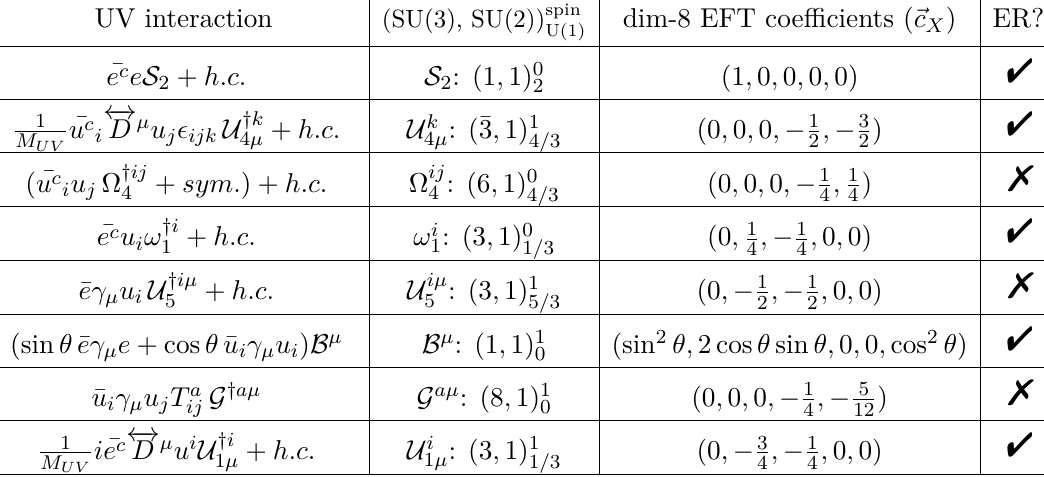
Table 5 . Potential ERs and the corresponding UV states for the amplitude cone positivity bounds of operators (7.1)–(7.5). ( SU (3), SU (2)) spin denotes the quantum numbers of the UV particles U(1) charged under the symmetries of the SM. The “dim-8 EFT coefficients” column represents pERs that can be constructed from group projectors or by integrating out the corresponding UV particles. The “ER?” column specifies whether a pER is really an ER or not. e c denotes the charge conjugate of e